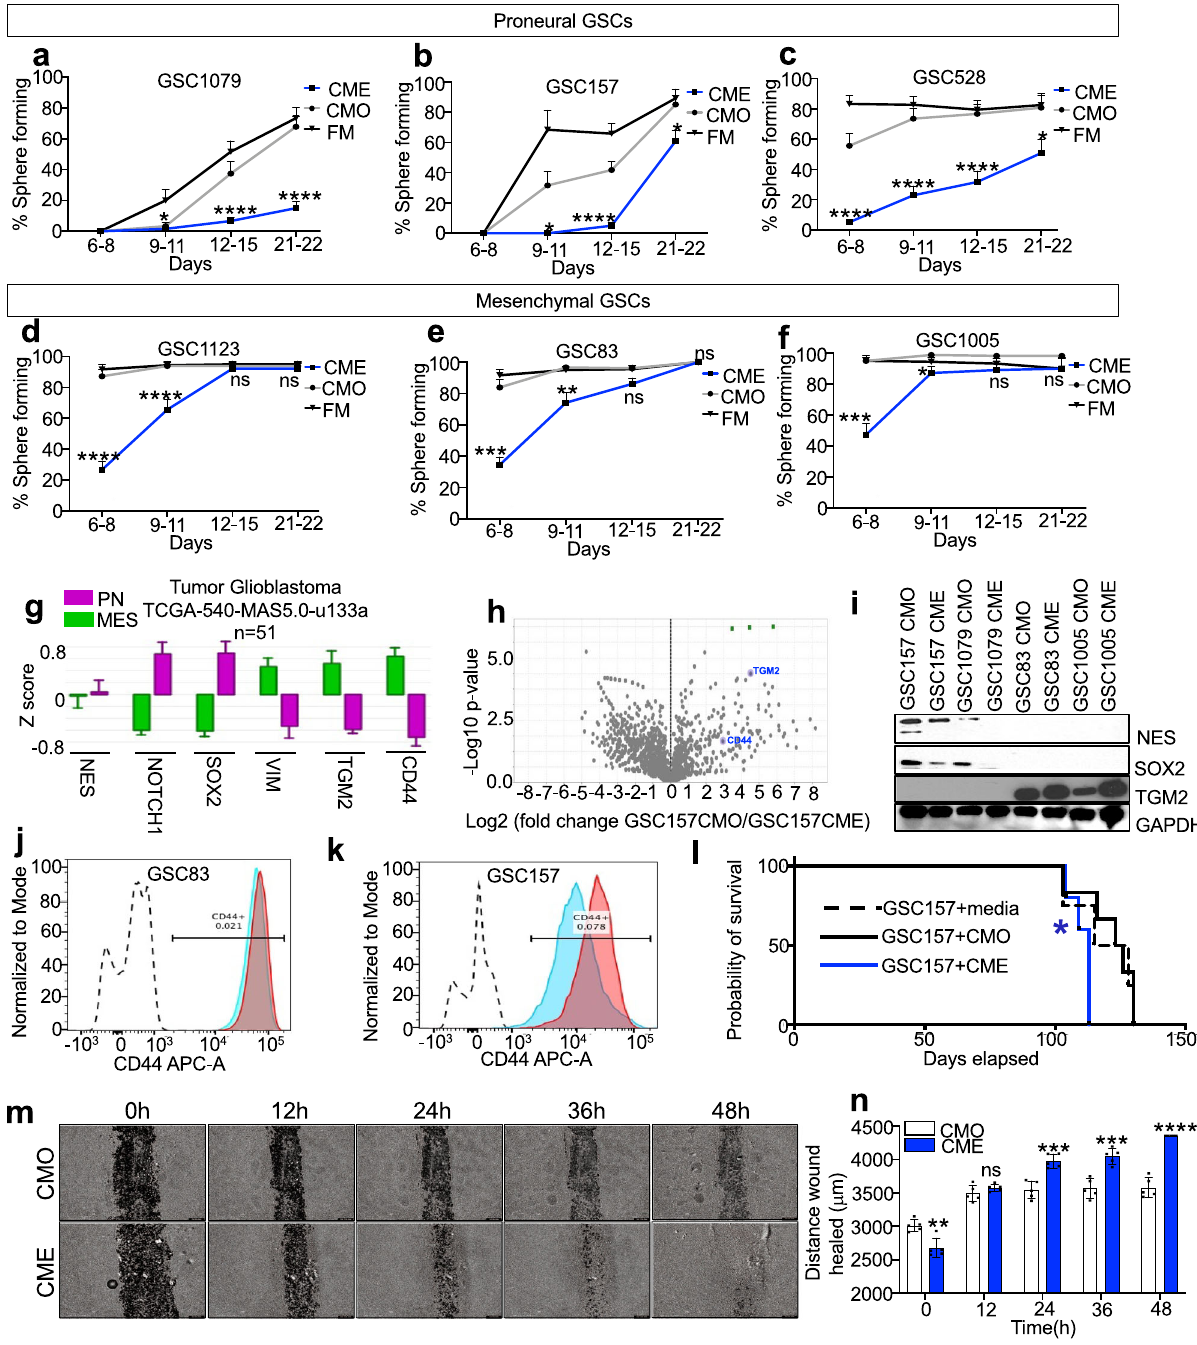
Fig. 3 | Mesenchymal reprogramming of proneural glioma cell stemness by endothelial conditioned media. Time-dependent changes in clonogenicity (ELDA)ofGSCs in the presenceof endothelialconditionedmedia (CME)or control media (CMO), compilation of limiting dilution assays across three proneural GSC lines: GSC1079 ( a ), GSC157 ( b ), GSC528 ( c ) and three mesenchymal GSCs lines: GSC1123 ( d ), GSC83 ( e ), GSC1005 ( f ); black lines represent cells treated with fresh media (FM), gray lines are indicative of cells treated with CMO, and blue lines represent cells treated with CME; n =3 each group and each time point. g TCGA dataminingofproneuralversusmesenchymalgeneticsignaturesacross51patients diagnosed with GBM. Proneural hallmarks include, but are not limited to, NES, NOTCH1 and SOX2. Mesenchymal hallmarks include, but are not limited to, VIM, TGM2 and CD44. Green and purple represent mesenchymal (MES) and proneural (PN) genetic signatures, respectively. h Volcano plot showing enriched mesench- ymalmarkersdetected inthemassspectrometry(MS)ofCMEtreatedGSC157cells